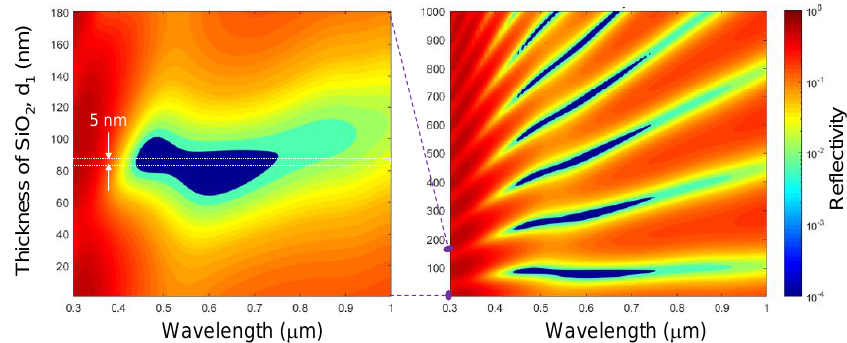
Figure 4. Plots of the simulated reflectivity R spectrum of a thin-film stack (Figure 2a) SiO absorber, where the mirror layer was Ti d m = 100 nm; note the logarithmic scale of R . The thickness of d 1 was varied from 0 to 180 nm (left panel) to determine the minimum of R which was the first layer SiO 2 found at d 1 = 84.8 nm. The darkest blue region has ≤ 1.3% reflectivity in the 430–960 nm spectral range. Other parameters are: d 2 = 7.9 nm, d 3 = 93.7 nm, d m = 100 nm and normal incidence θ = 0 ◦